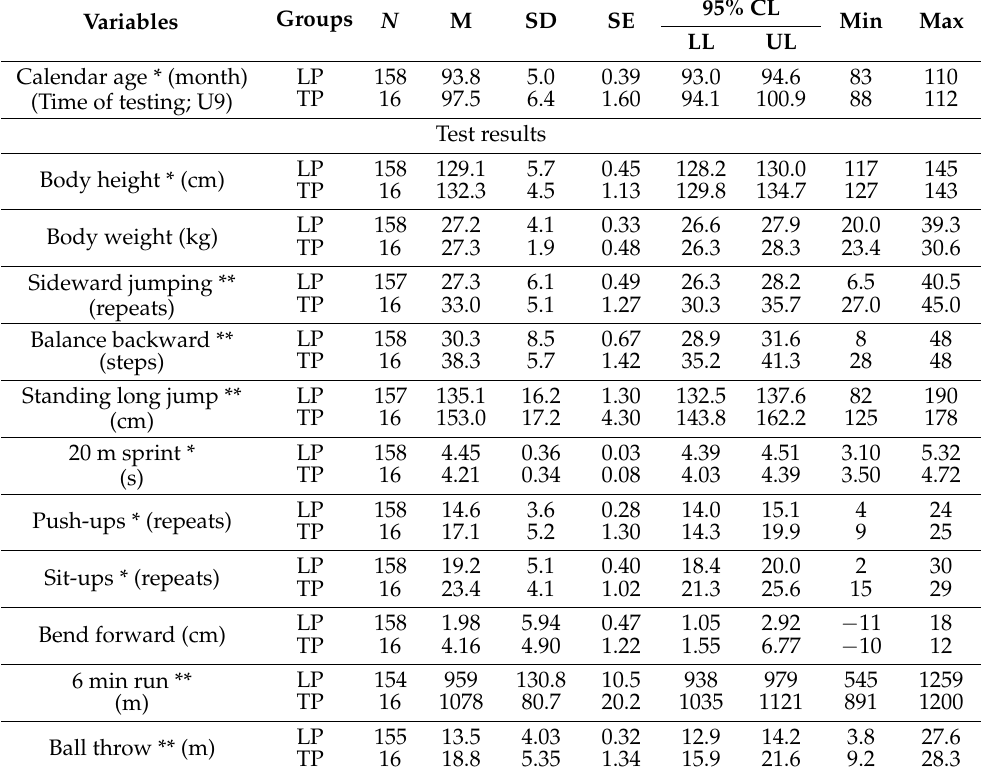
Table 3. Descriptive statistics for the two anthropometric, five physical fitness, and four motor competence diagnostics of the U9